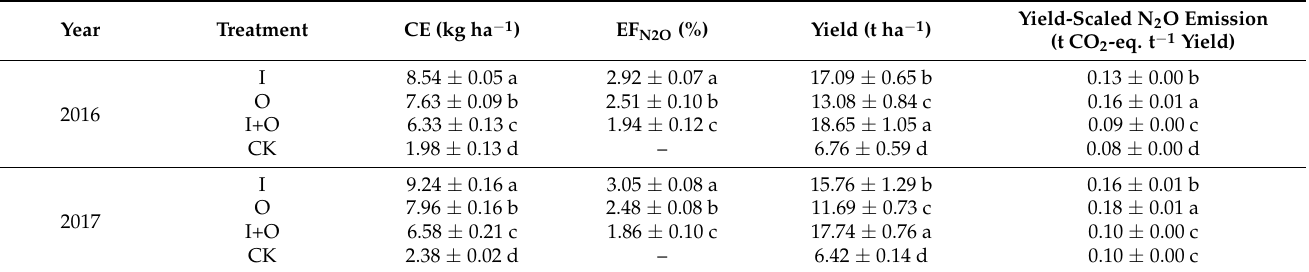
Table 2. Seasonal cumulative N 2 O–N emissions, EF N2O , yield and yield-scaled N 2 O emission under different treatments in two growing seasons of purple caitai.